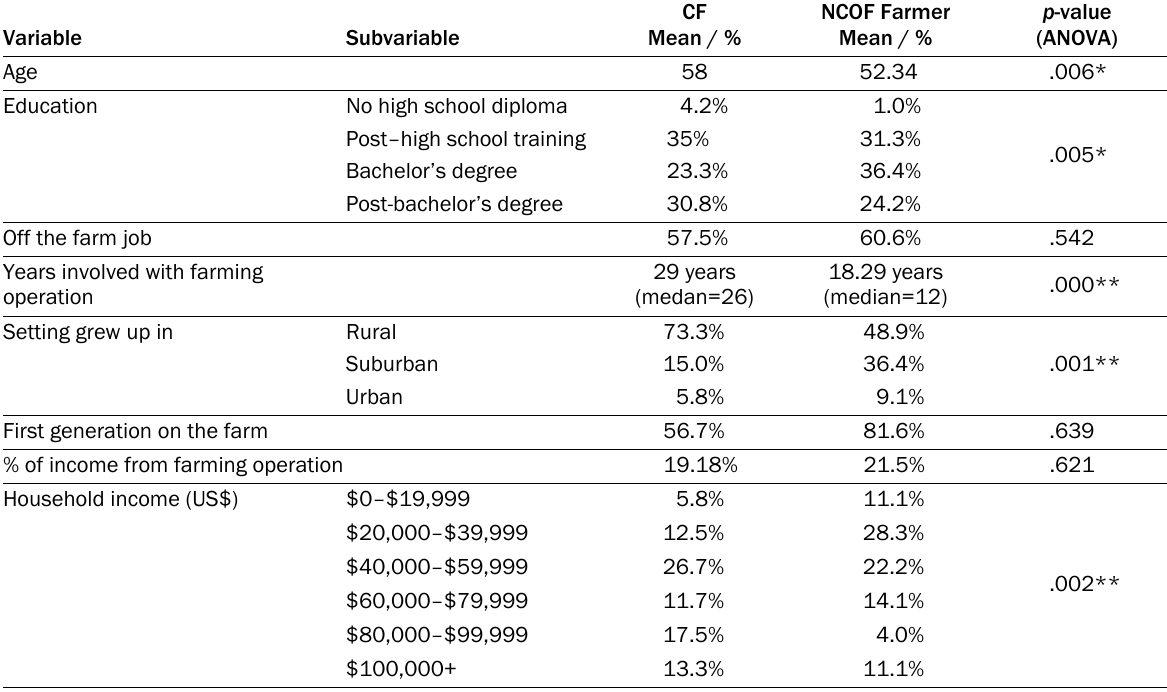
Table 2. Summary Demographic Statistics and T-test for CF vs. NCOF (numbers given are valid percent of n